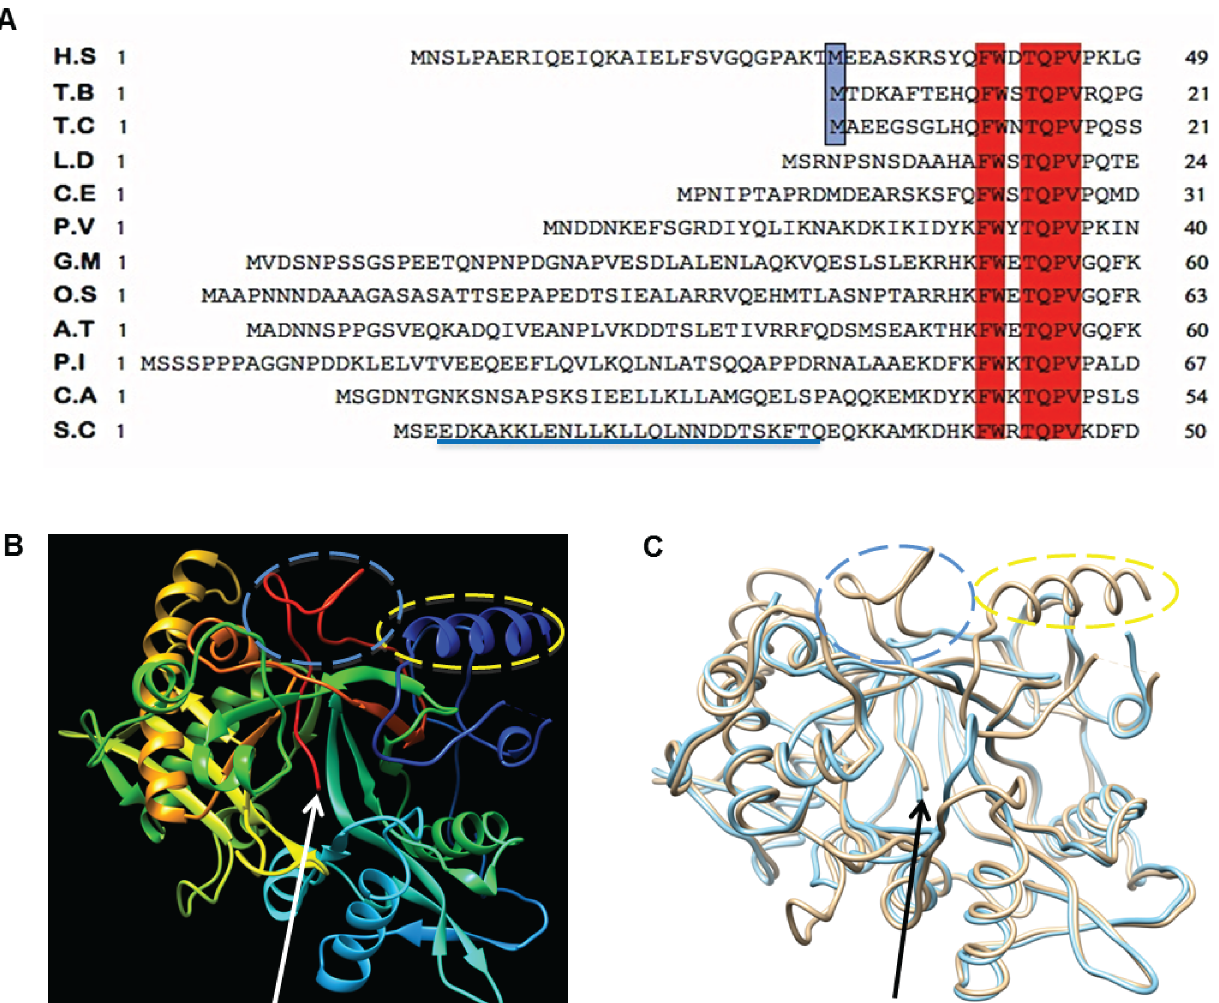
Fig 1. Sequence comparisons of the N-terminal region and structure analysis of NMT. A , N-terminal amino acid sequence alignment of orthologous NMT from different species. The comparative alignment of H.S ( Homo sapiens ) sequence is shown with representative organisms T.B ( Trypanosoma brucei ), T.C ( Trypanosoma cruzi ), L.D ( Leishmania donovani ), C.E ( Caenorhabditis elegans ), P.V ( Plasmodium vivax ) A5K1A2), G.M ( Glycine max ), O.S ( Oryza sativa ), A.T ( Arabidopsis thaliana ), P.I ( Phytophthora infestans ), C.E ( Candida albicans ) and S.C ( Saccharomyces cerevisiae ). All sequences were obtained from the SwissProt protein database [27] and their accession numbers are listed under “ Materials and methods ” . The first conserved residues across all sequences are shown in red boxes. The initiator methionine corresponding to Δ 28 N-terminal truncation of hNMT1s and its conservation with T.B and T.C NMT is boxed in light blue . The sequence region corresponding to the ordered N-terminal region of Yeast NMT is underlined blue. B , Ribbon diagram representing the locations of ordered N-terminal region and interacting C-terminal portion in three-dimensional structure model of yeast NMT (Protein Data Bank entry 2P6E, chain C). The ordered α -helical and loop region of N-terminus portion are shown in blue and indicated by a dotted ellipsoid ( yellow ). The location of the insertion in C-terminal portion located between β n 0 and β o 0 ( red ) is indicated by the dotted ellipsoid ( blue ) which is in proximity to the ordered region of N-terminus (shown in blue and encircled by yellow dotted ellipsoid) C , Structural superimposition of the three-dimensional model based structure of yeast and hNMT1s (Protein Data Bank entry 2P6E, chain C and 3IU1, chain A respectively). The light brown and light blue ribbon traces correspond to yeast and human NMT, respectively. The ordered N-terminal region of yeast NMT is indicated by a dotted ellipsoid ( yellow ) and the differences in the sequence length between β n 0 and β o 0 regions are indicated by a blue dotted ellipsoid. The arrowhead in B and C indicate the C-terminal tip of the